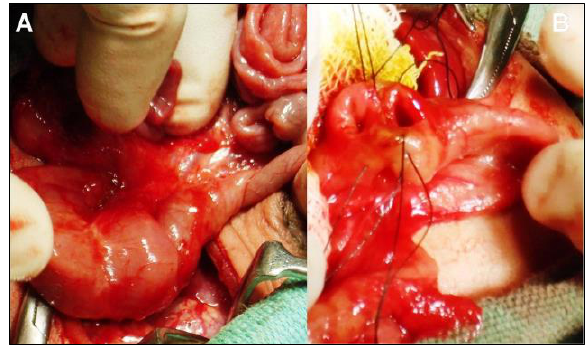
Figure 3: Intra-operative images showing dilated duodenum till third part (fibrotic ring extra-luminally) of duodenum with a change in the caliber beyond it (A); Enterotomy and circumferential excision of web (membrane) at the third part of duodenum completed.